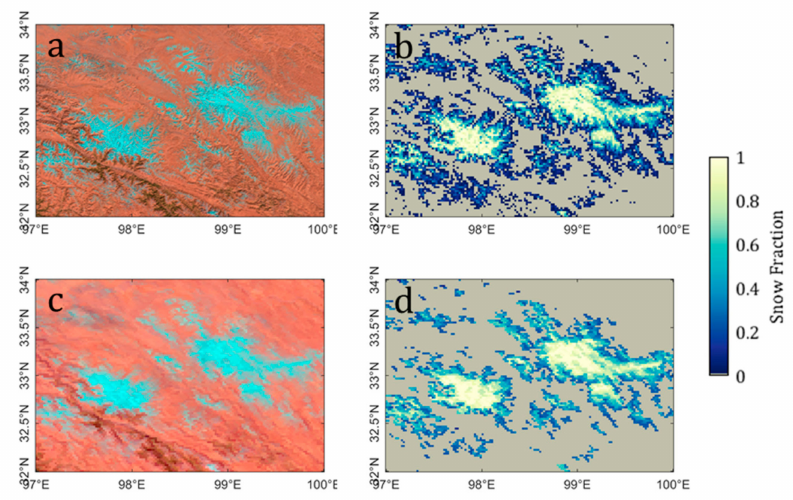
Figure 11. A case evaluation of Himawari–8 AHI fractional snow cover with MOD10A1: ( a ) the Terra MODIS image (bands 5, 4, and 3) of an eastern part of the Tibetan Plateau on 10 December 2016; ( b ) the corresponding MOD10A1 fractional snow cover; ( c ) the corresponding Himawari–8 AHI image at UTC 4:20 a.m.; ( d ) the Himawari–8 AHI fractional snow